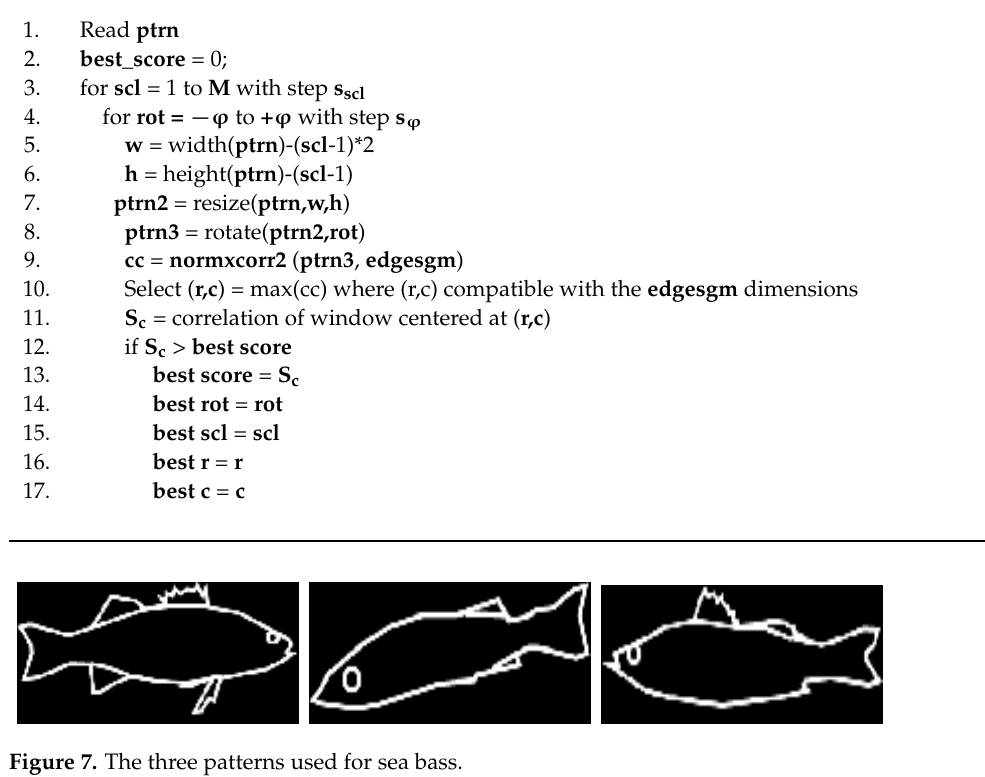
Figure 6. Sliding a resized and rotated fish pattern in the original gray scale image.